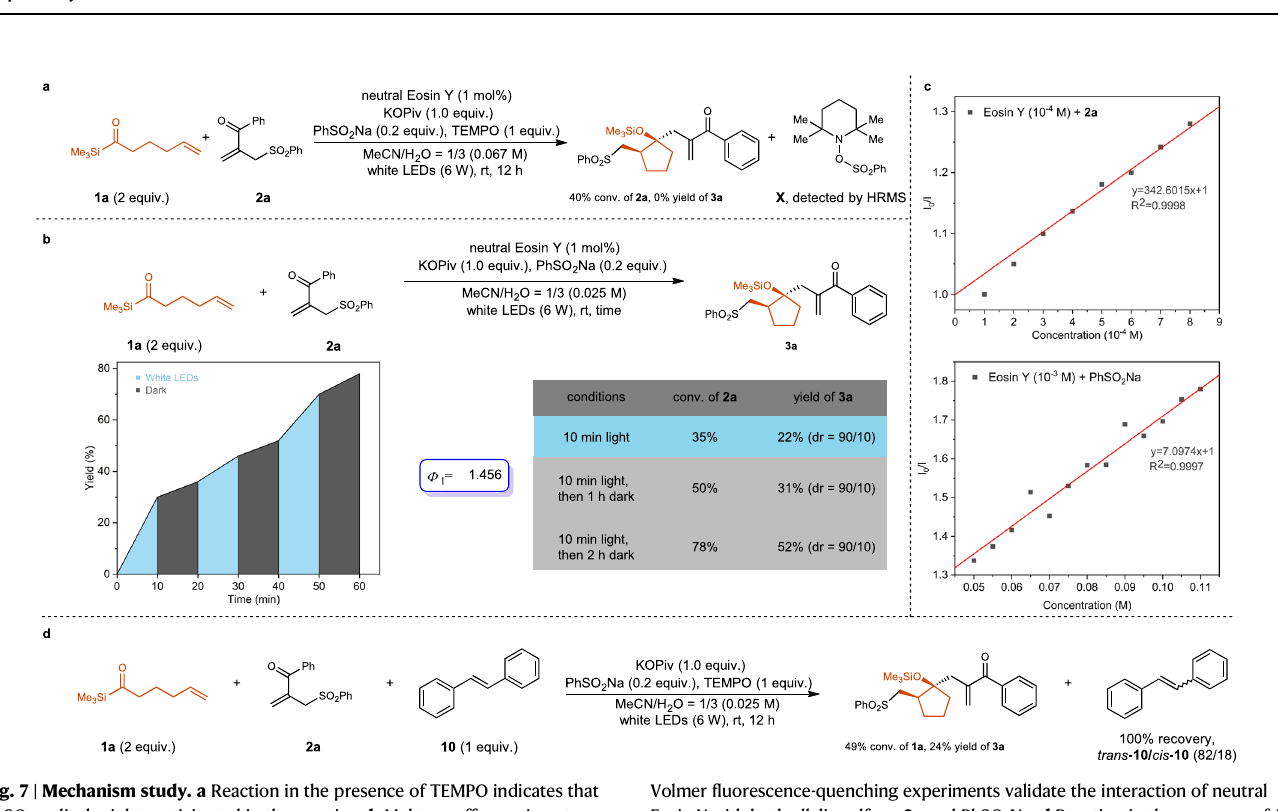
Volmer fl uorescence-quenching experiments validate the interaction of neutral Eosin Y with both allylic sulfone 2a and PhSO 2 Na. d Reaction in the presence of E - stilbeneinsteadofEosinYsupportstheenergytransferfromexcitedacylsilaneto E - stilbene. Source data are provided as a Source Data fi